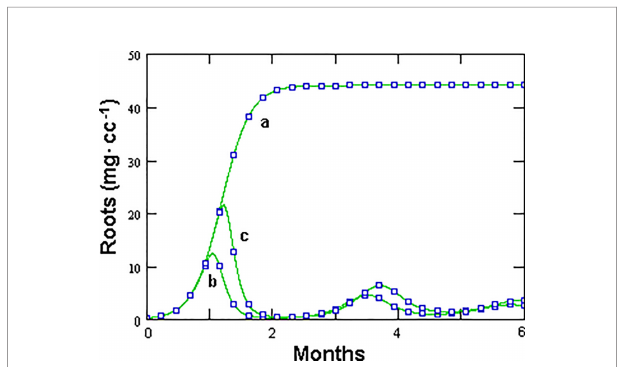
FIGURE 7 | Effect of the initial number of healthy eggs, as unique nematode source, on root growth, as modeled by GPNRd, with X 0 = 0 (a) , X 0 = 1 (b) , and X 0 = 100 (c) eggs in 1 cc rhizosphere microcosm.